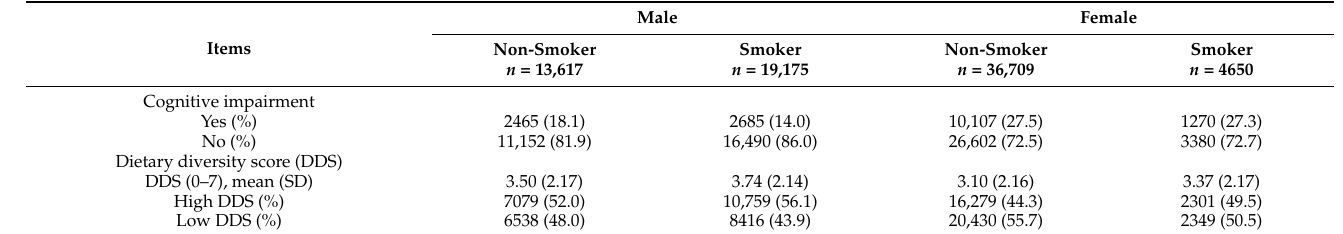
Table 3 presents the results of “diet–smoking–gender” three-way interaction effects on cognitive impairment based on GEE logit regression models of six waves of the CLHLS (2002–2018), with DDS as a dichotomous variable. The results indicated that after adjusting for all the